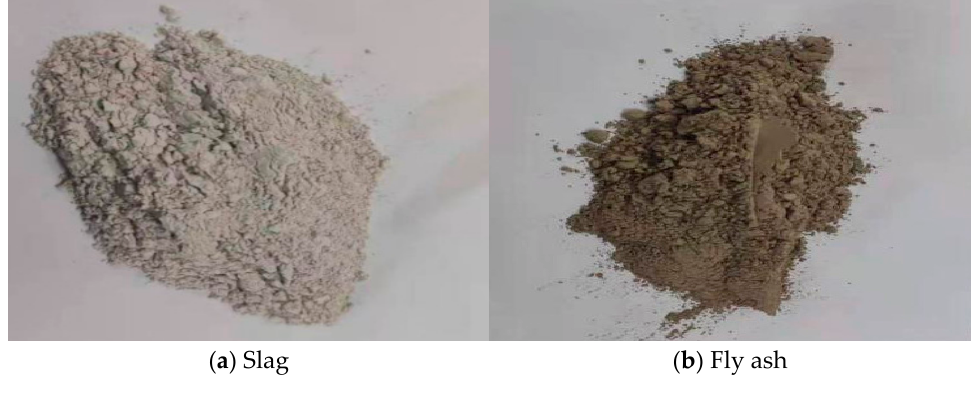
Figure 2. Slag and fly ash samples. ( a ) Slag; ( b ) Fly ash. Table 1. Main chemical composition and ignition loss of slag, fly ash, and cement.